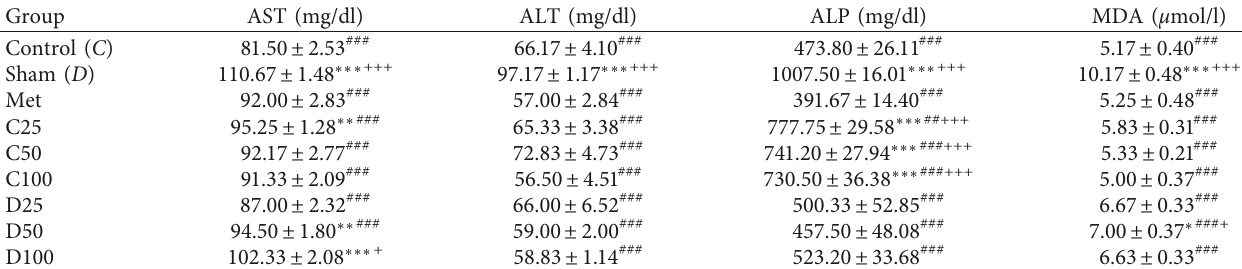
Table 2: Results of the AST, ALT, ALP, and MDA in diabetes rats and